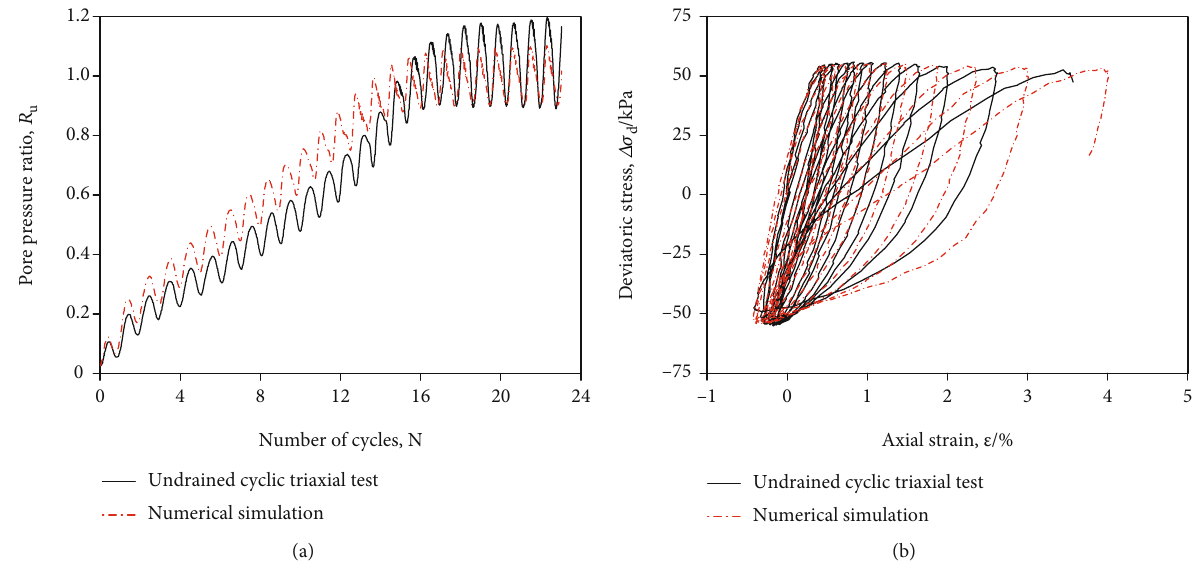
Figure 11: Pore pressure ratio-number of cycles and stress path of undrained cyclic triaxial test.